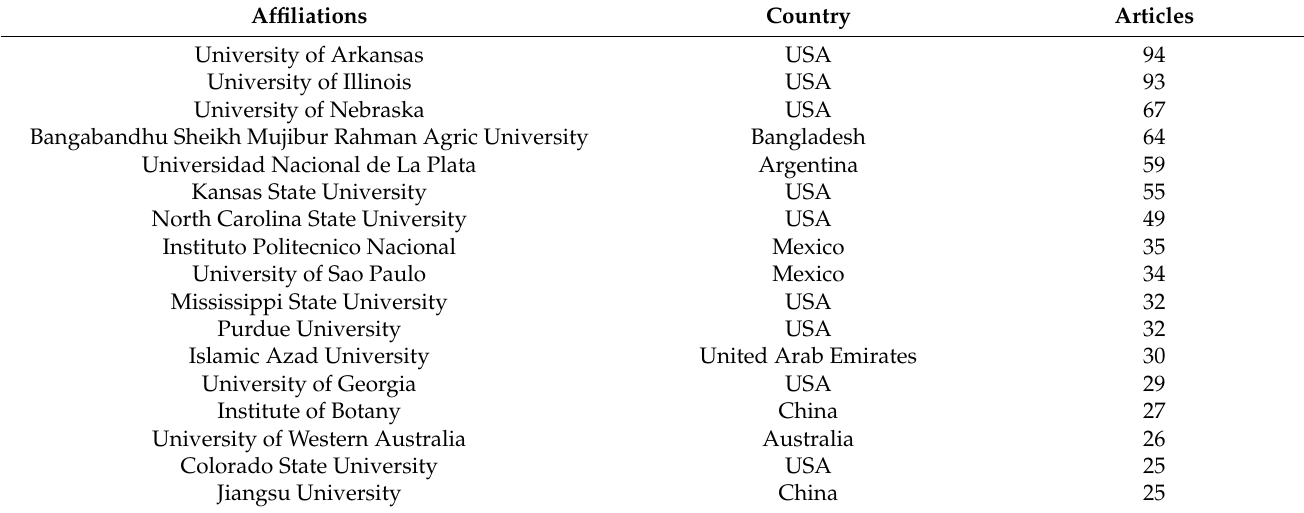
Table 3. Top 20 most relevant institutions on amaranth research from 2011 to 2020.